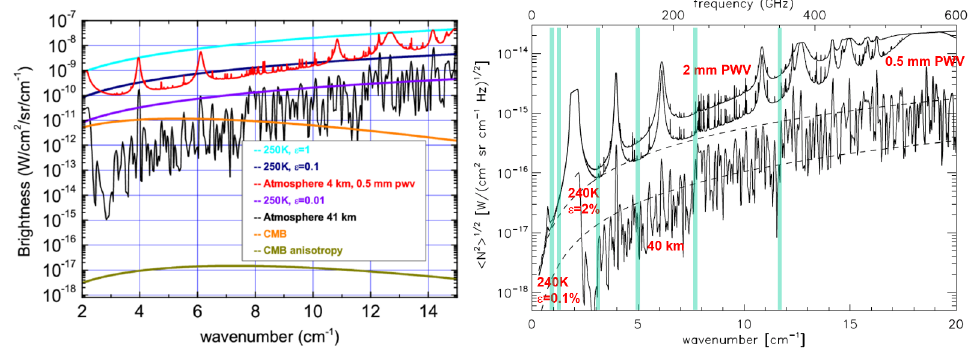
Figure 2. Left: atmospheric brightness in the mm range. Right: quantum fluctuations of the brightness. Both are shown for di ff erent altitudes. The dashed lines in the right panel represent the brightness fluctuations of room temperature optical systems, for low and high extreme values of their emissivity (2 % and 0.1 %).